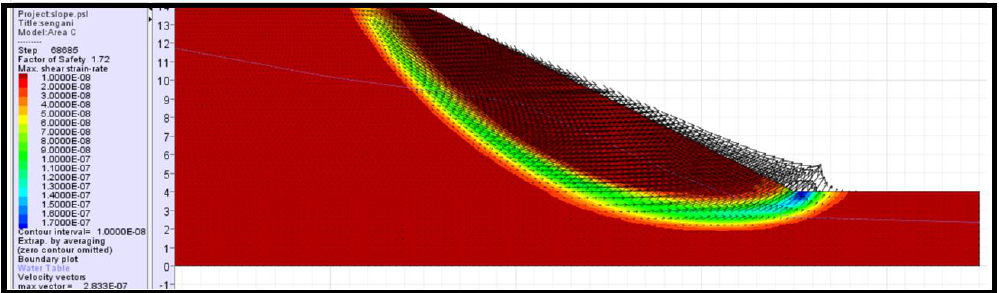
Figure 31. Simulated FoS of the clay loam soil slope using FLACSlope in sunny with a water table with 1000 m 3 volume of water. Note that maximum shear strain simulated ranges between 2.500 × 10 − 8 to 4.989 × 10 − 7 . Appl. Sci. 2020 , 10 , x FOR PEER REVIEW 26 of 33